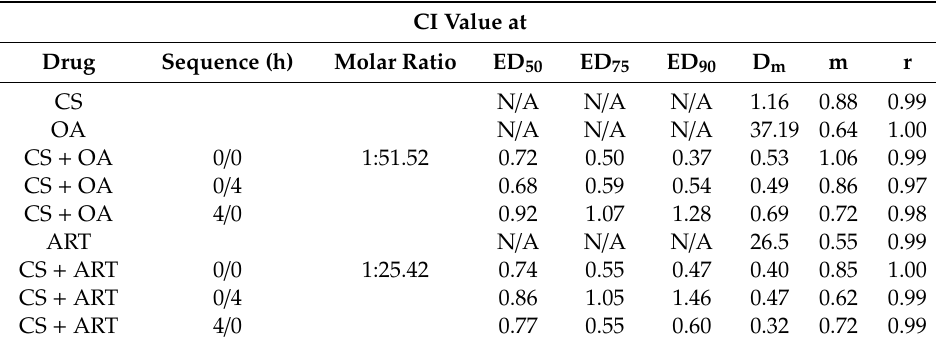
Table 2. Combination index (CI) values of CS with OA and ART in the A2780 cell line, where drugs were added in equipotent ratios based on IC 50